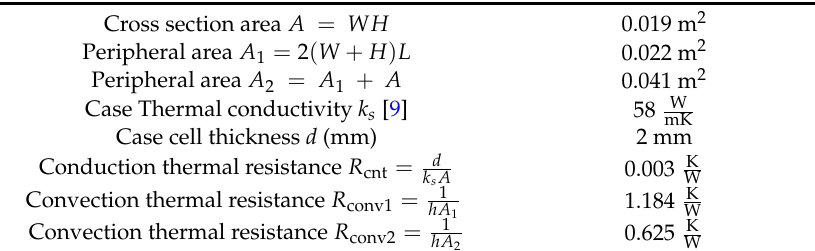
Table 2. Physical and thermal Battery Pack